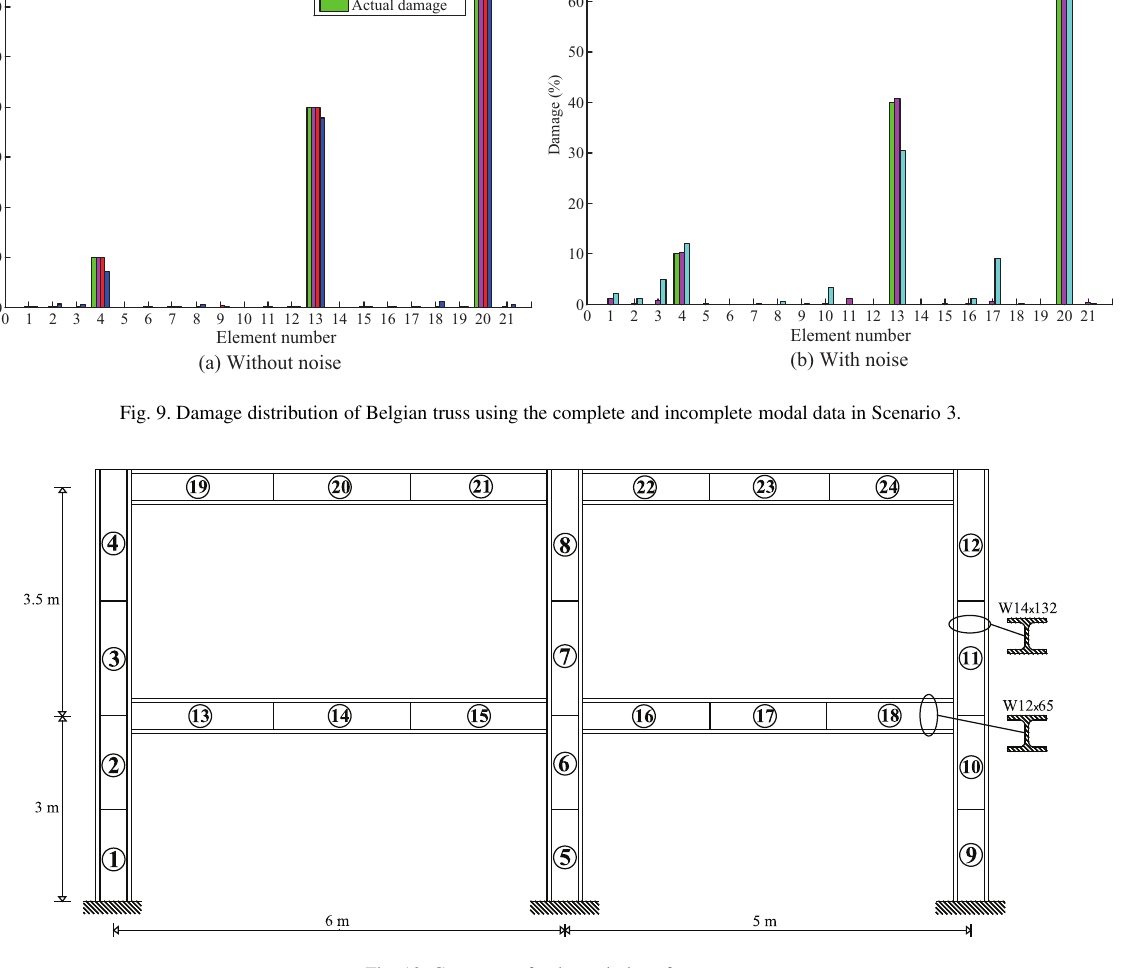
Fig. 10. Geometry of unbraced plane